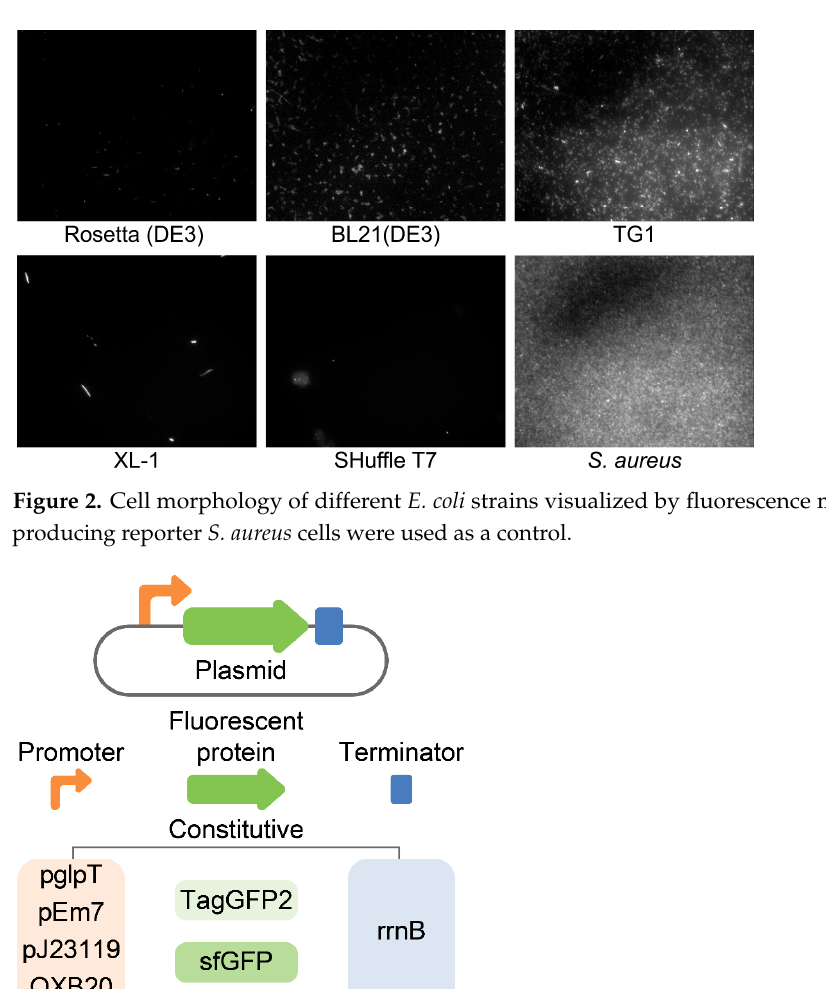
Figure 3. A panel of plasmids that were used for the optimization of E. coli -based live biosensors. All genetic constructs were constructed on the same high-copy number template vector. Two different fluorescent proteins, i.e., TagGFP2 and sfGFP, were used. Constitutive (pglpT, pEm7, pj23119, and OXB20) and inducible (T7) promoters were compared in terms of efficiency, homogeneity of cell fluorescence, and